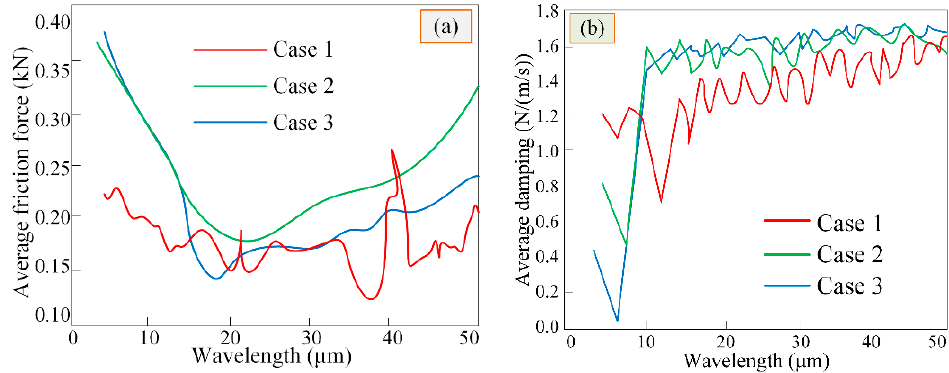
Figure 12. Averaged values with multiplex wavelengths ( a ) Frictional forces, ( b ) Damping values.